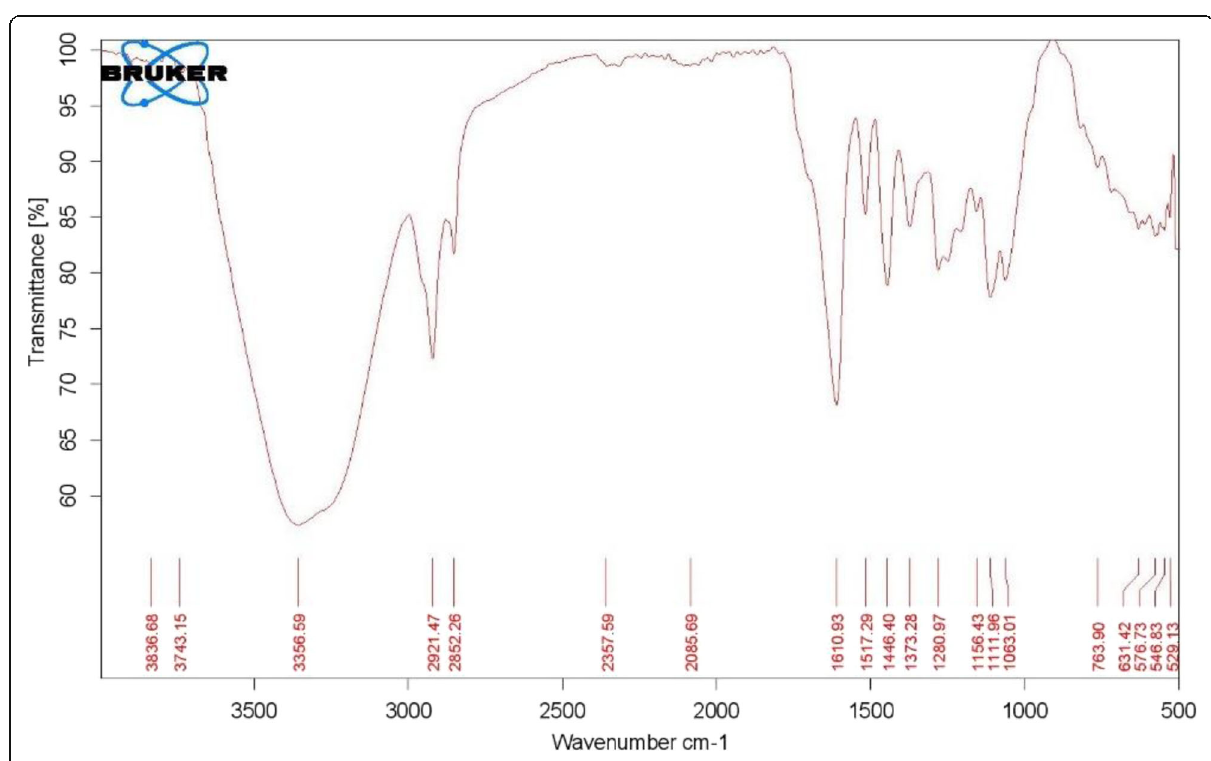
Fig. 3 The FTIR spectrum showing peak values of hydro-methanolic root